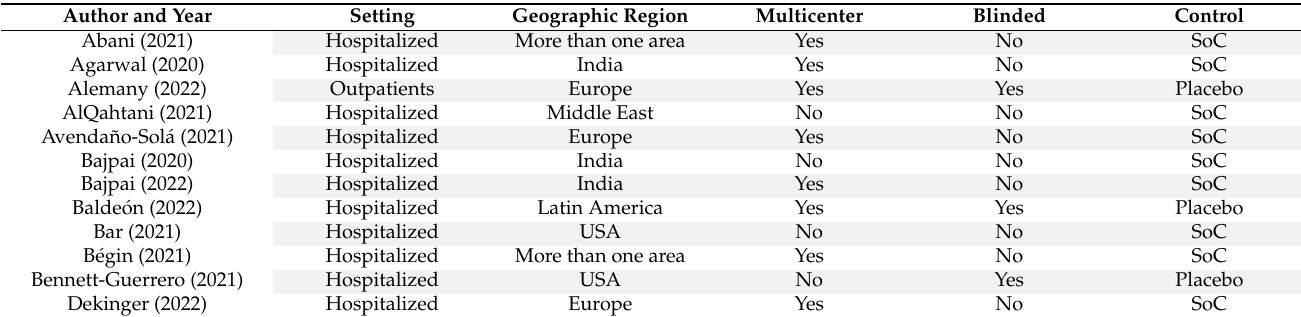
Table 1. General characteristics of the included studies.